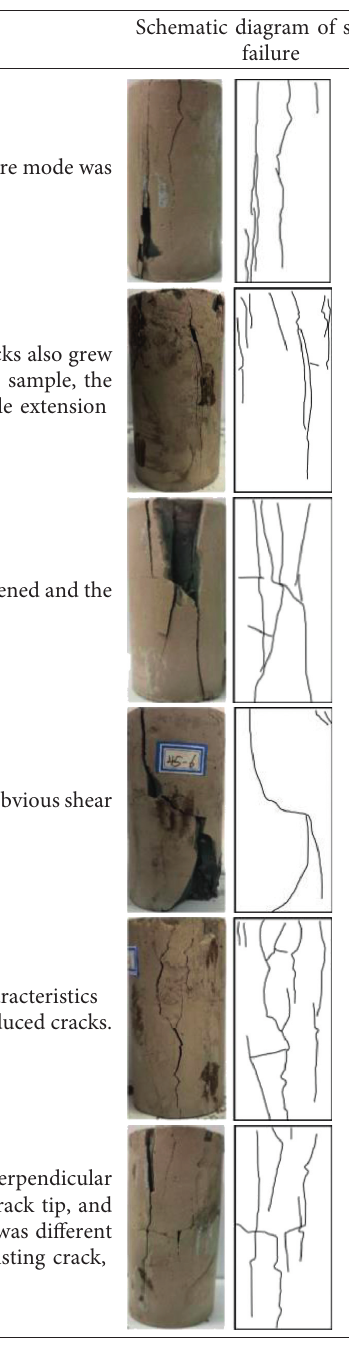
Table 2: Description of the failure process of the sample with different angles of